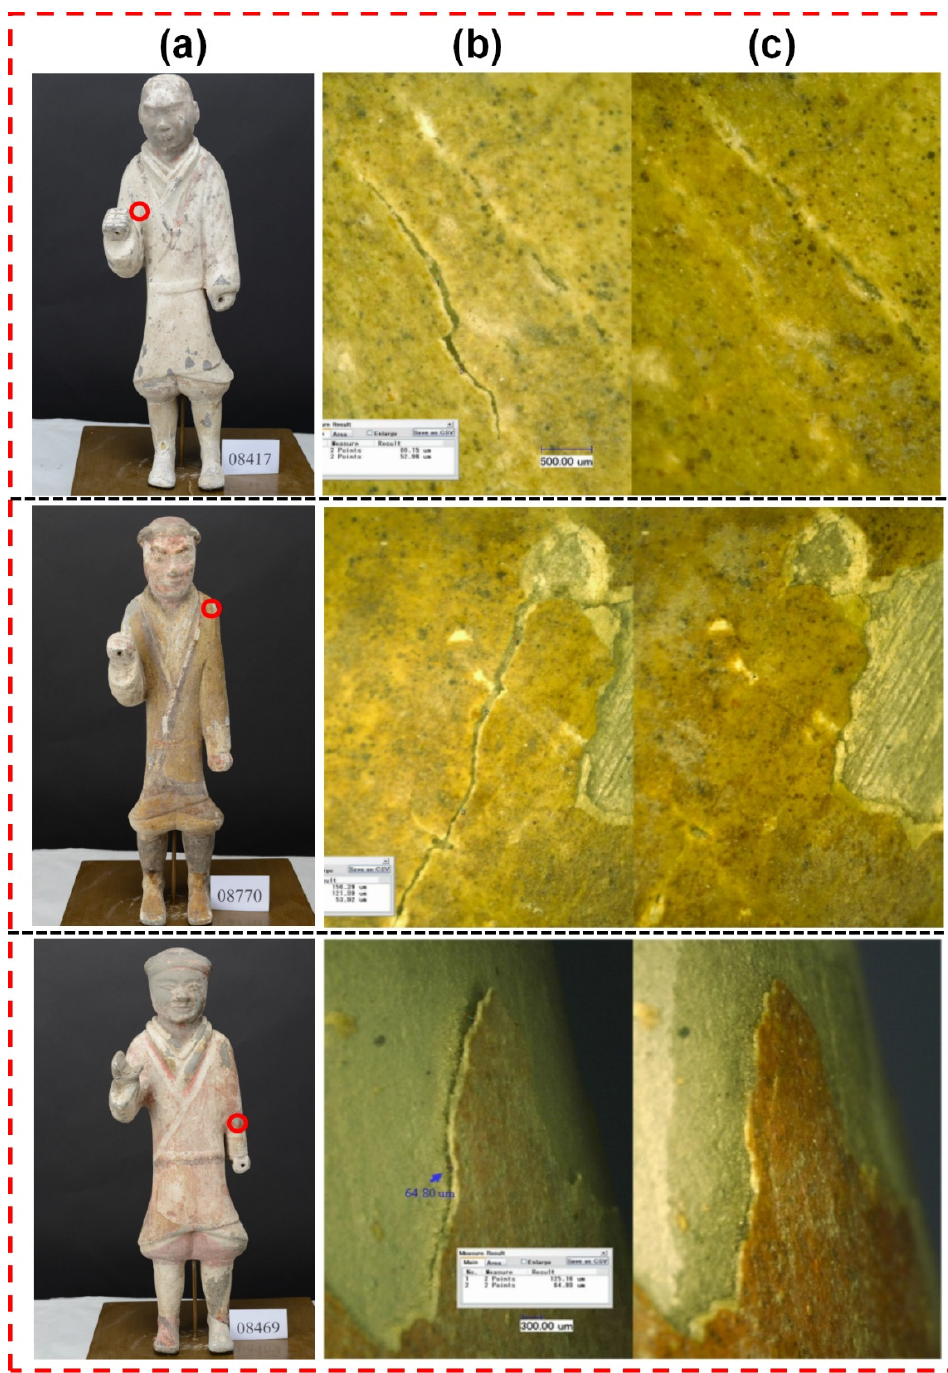
Figure 10. Restoration effect of the painted layer (( a ) pottery, ( b ) untreated, ( c ) treated).